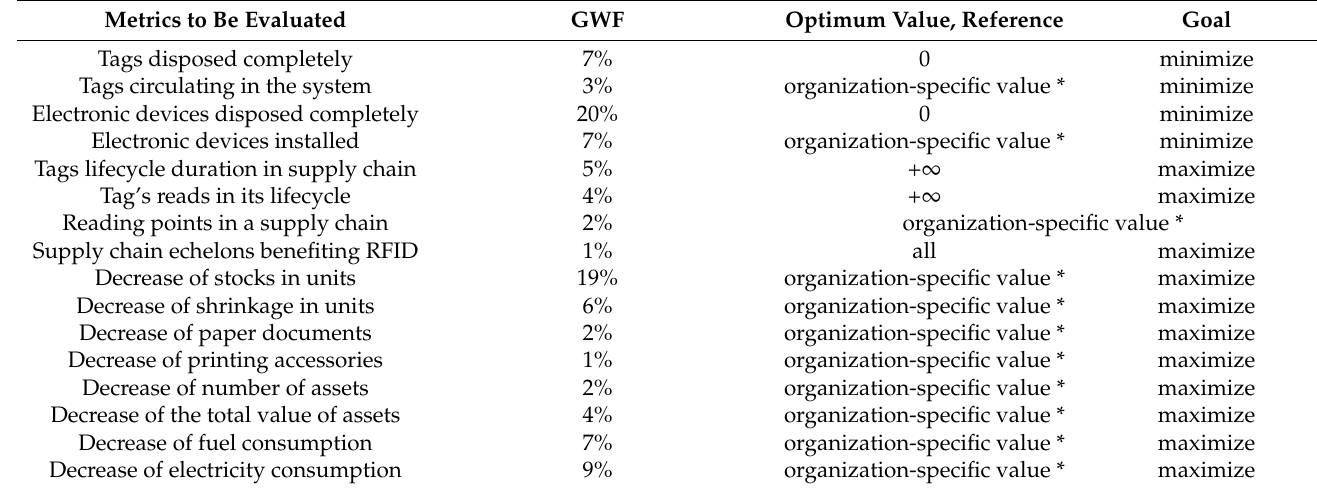
Figure 4. Lifecycle-based measures used in LCA for RFID+WSN systems. Table 4. General LCA indicator descriptions for RFID+WSN technology.